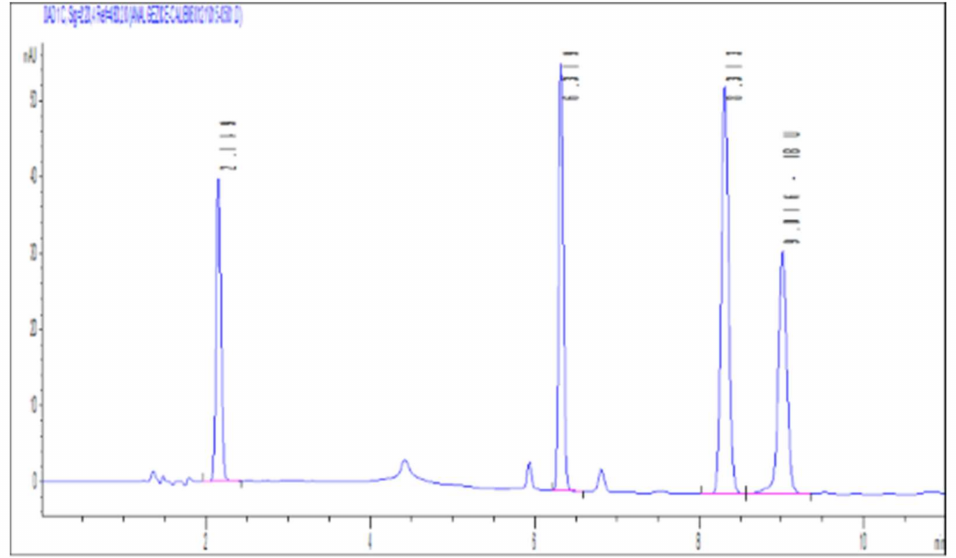
Figure 1. Chromatogram obtained by analyzing a mixed solution of ACF, KTF, DCF, and IBF at 4 wavelengths corresponding to the absorption maximum.